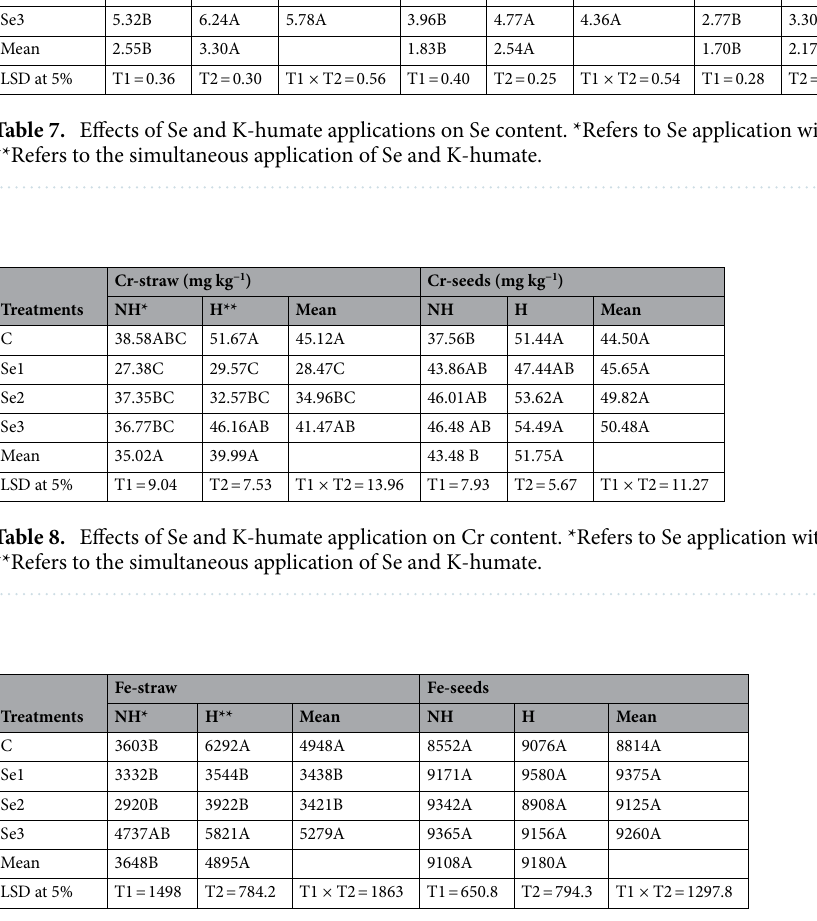
Table 9. Effects of Se and K-humate applications on Fe content. *Refers to Se application without K-humate. **Refers to the simultaneous application of Se and K-humate.